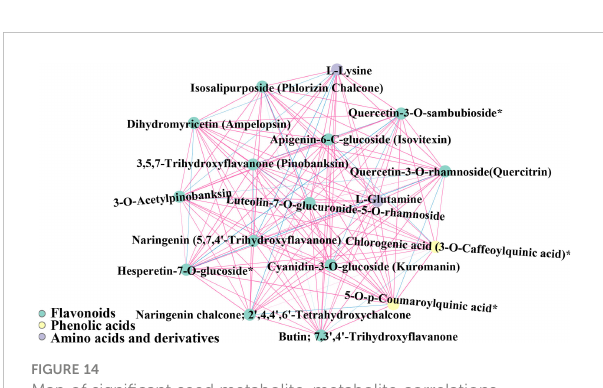
FIGURE 14 Map of signi fi cant seed metabolite-metabolite correlations. Metabolites are represented by circles, and the same color indicates metabolites in the same metabolic function group. Correlations are indicated by connected lines. Positive correlations are red and negative correlations are blue. The thickness of the line represents the magnitude of the absolute value of Pearson ’ s correlation coef fi cient r. The thicker the line, the larger the